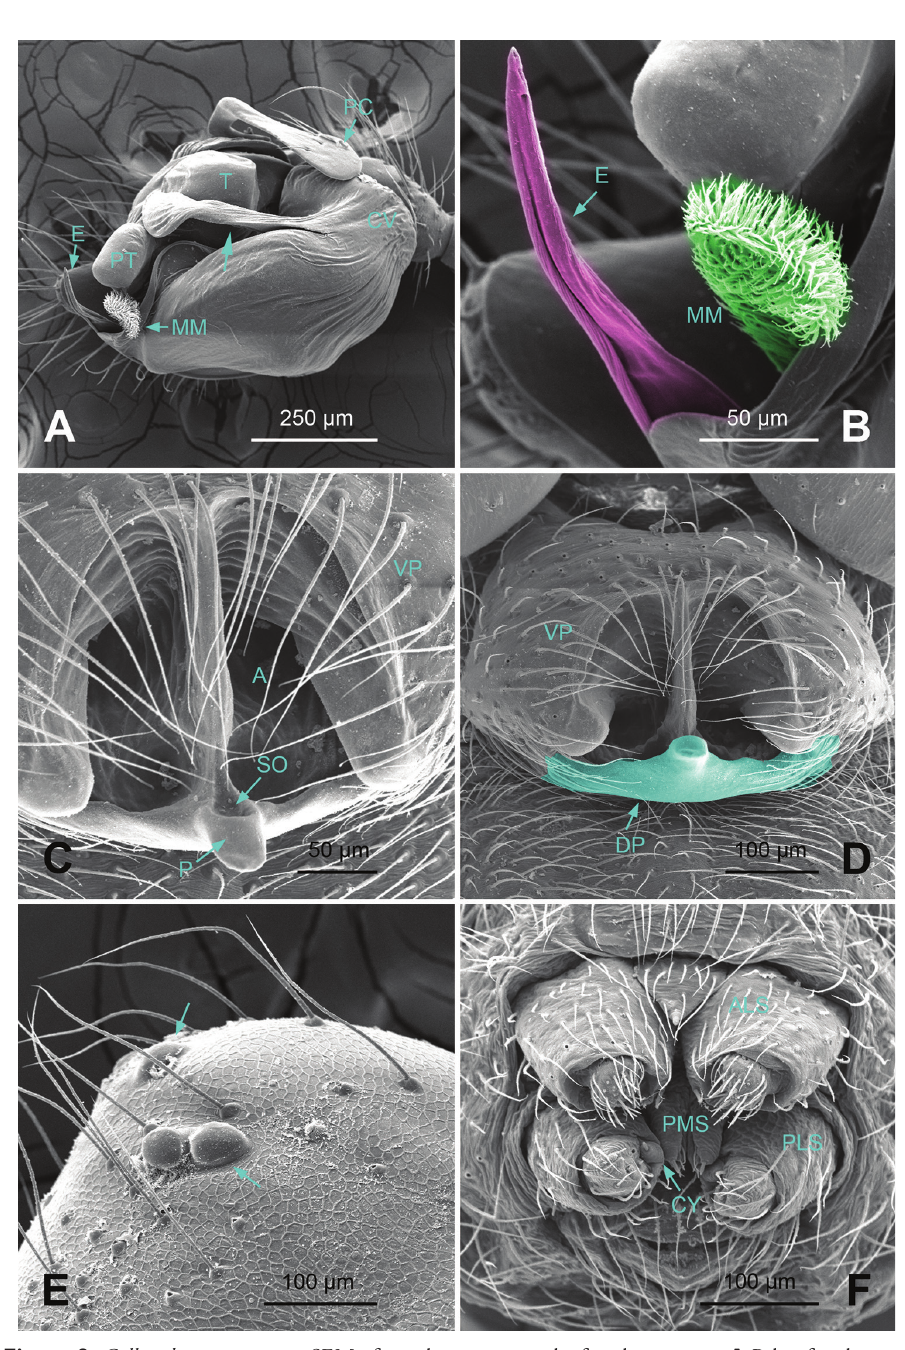
Figure 8. Callosa baiseensis sp. n., SEM of a male paratype and a female paratype. A Palp of male para- type, ventral view B Detail showing embolus and embolic membrane C Detail showing scape of epigyne D Epigyne of female paratype, ventral view E Anterior lateral eye, anterior median eye and posterior lateral eye of male paratype F Spinnerets of female